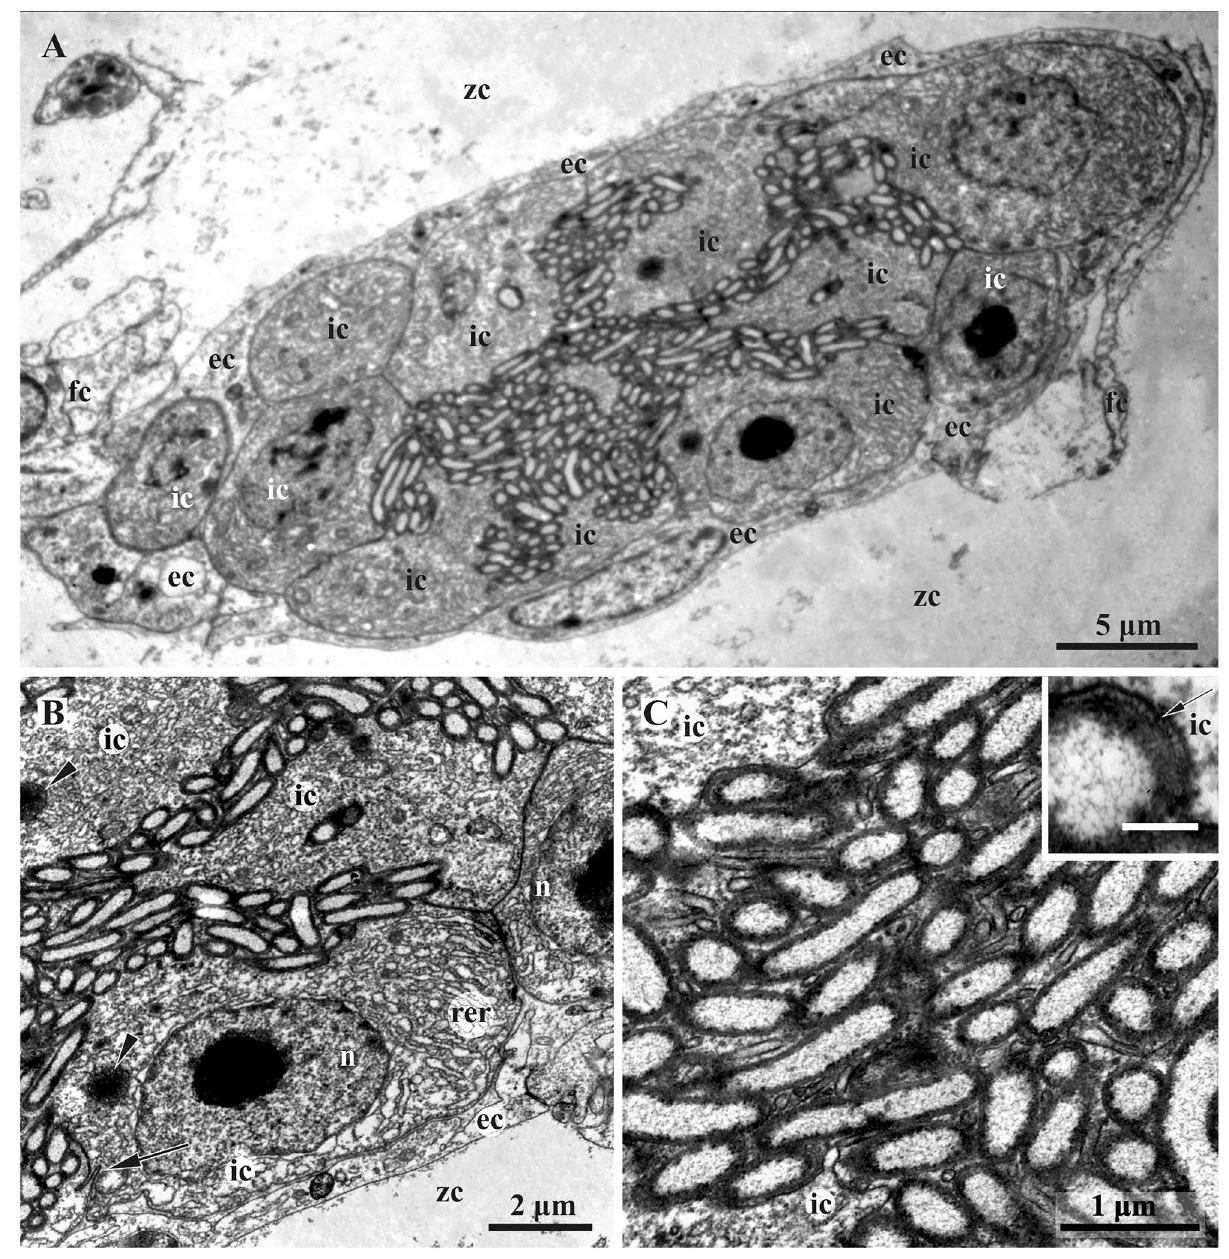
Figure 4. Early funicular body of Dendrobeania fruticosa (collected on 23 June 2018) (TEM). ( A ) Whole view of early-stage funicular body. ( B ) Partial view of cavity and wall of early-stage FB showing external and inner cell layers (arrowheads: multivesicular bodies; arrow: adherens junction with Z-curve between cells). ( C ) Bacterial symbionts and microvilli formed by cells of inner layer. Inset: enlarged area showing bacterial pili (arrow). ec cells of external layer, fc cells of funicular cords, ic cells of inner layer, n nucleus, rer rough endoplasmic reticulum, zc zooidal overlap each other. They had an electron-translucent cytoplasm with a few organelles (elongated nucleus with prominent peripheral heterochromatin, sparse cisternae of rough cytoplasmic reticulum (RER), and some microvesicles). They resembled the funicular cells directly contacting them and sometimes giving the impression of the presence of a third cell layer (Figs. 4A, 5, inset, Fig. 6A). Overall, the external cells showed little evidence of synthetic or transport activity. The inner layer consisted of cuboidal and prismatic cells, some having long irregular outgrowths separating a FB cavity onto interconnected chambers/pockets densely filled with bacteria (Figs. 3A,B, 5, 6A). These cells had a distinct polarity: their flat basal membrane abutted the membrane of the cells of the outer layer, whereas the apical one formed multiple thin cytoplasmic processes (microvilli) protruding between bacteria (Figs. 4B,C, 5 and inset, Fig. 6A ‒ D). The lateral surfaces of the inner cells have tight contacts exhibiting a Z- or V-shaped